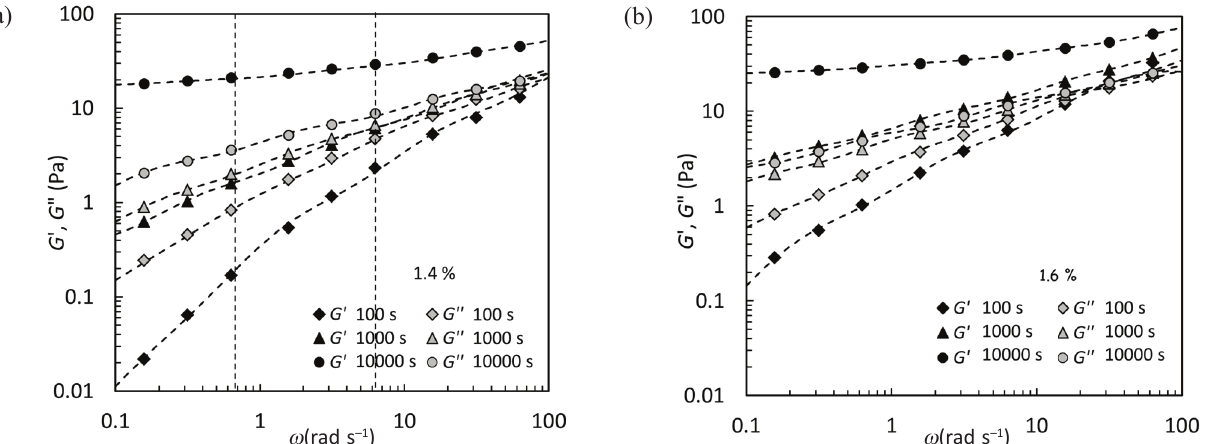
Fig. 3 – Mechanical spectra of systems 1.4 %wt (a) and 1.6 %wt (b) calculated at different process times (in seconds): 100 (diamonds), 1000 (triangles), 10000 (circles), black symbols (G'), grey symbols (G''). Lines in the figures represent the best fits of the experimental data obtained with the gM model (Eqs. (1') and